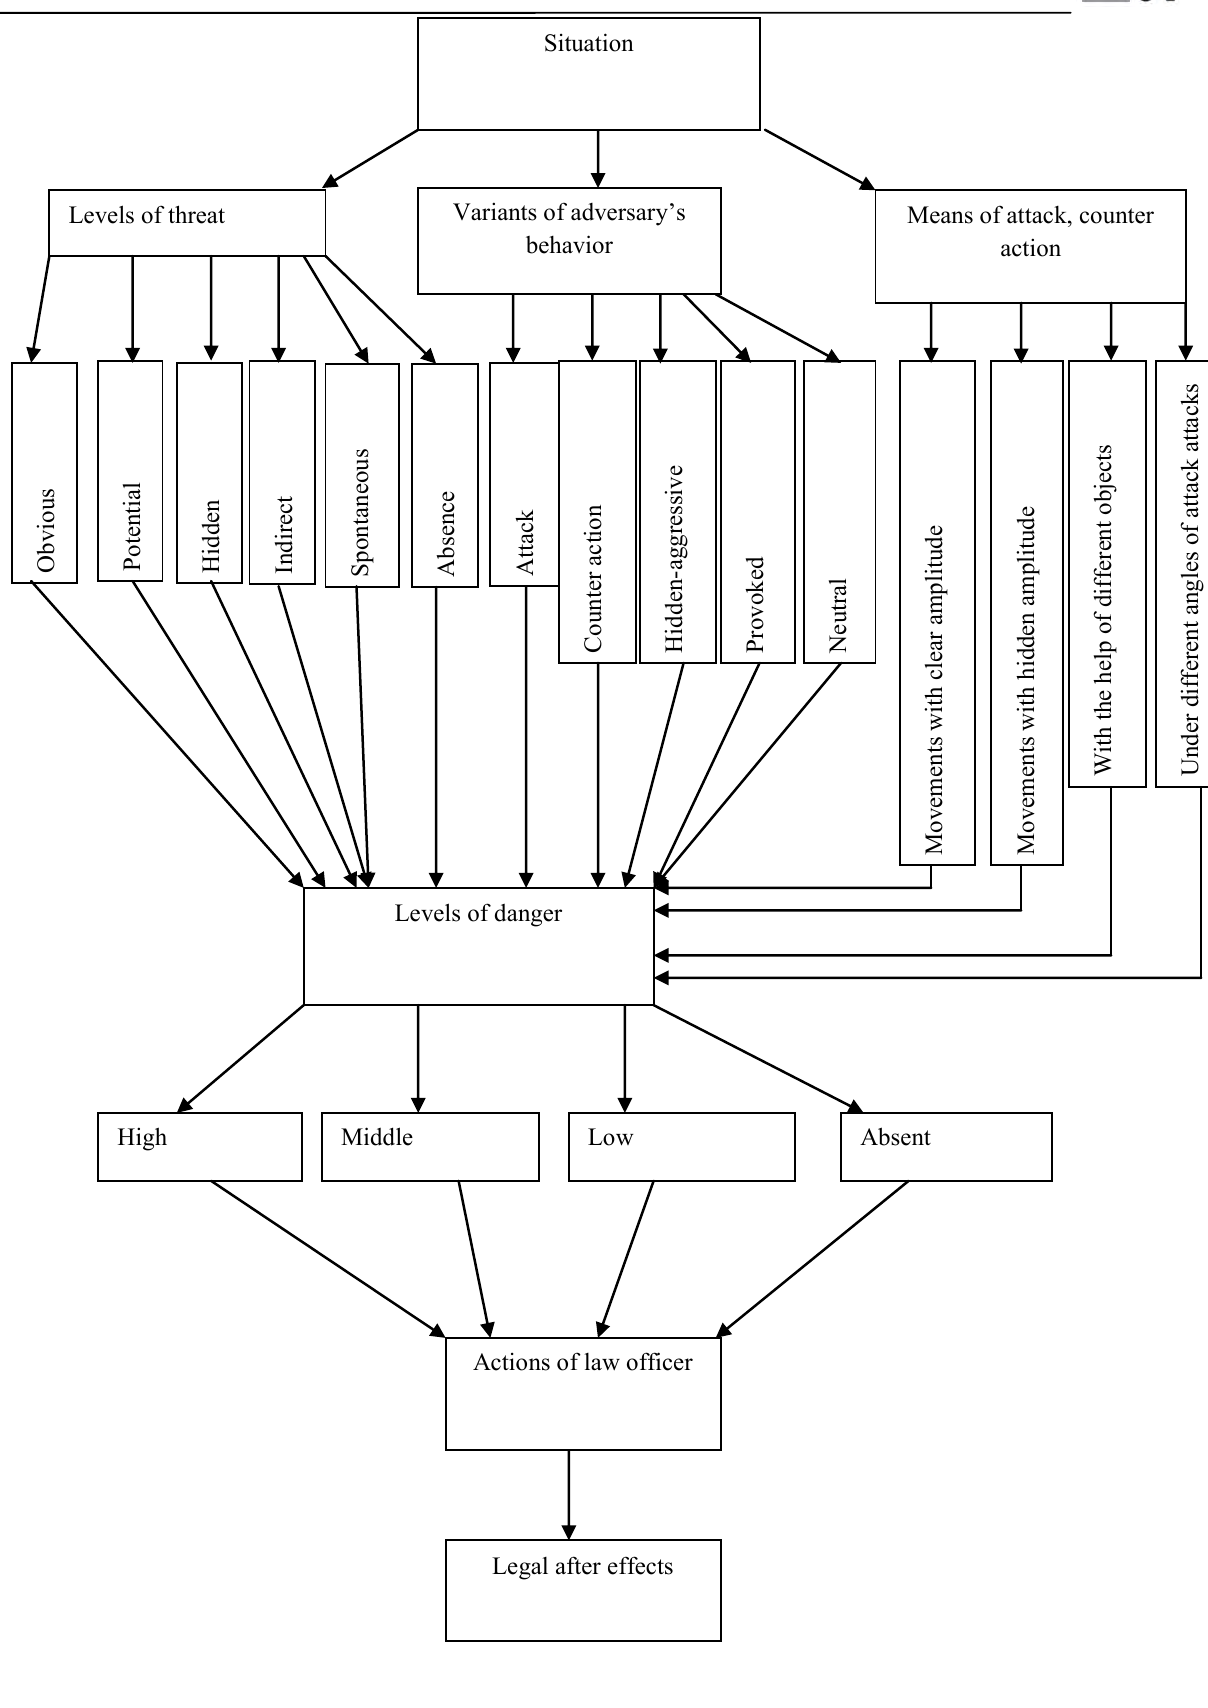
Fig.1 Variants if levels of threat and danger according to